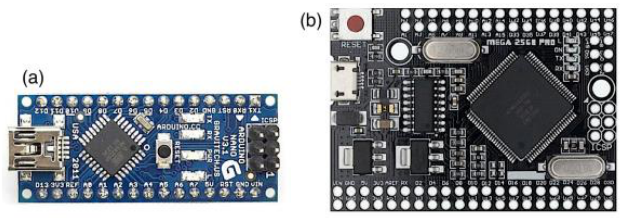
Figure 6. Platforms used for AVR testing: ( a ) Arduino Nano, ( b ) Arduino Mega Core. Microchip PIC18-based platform . This family of microcontrollers is considered to be low-to-middle-range, offering a set of features similar to AVR micros (RISC